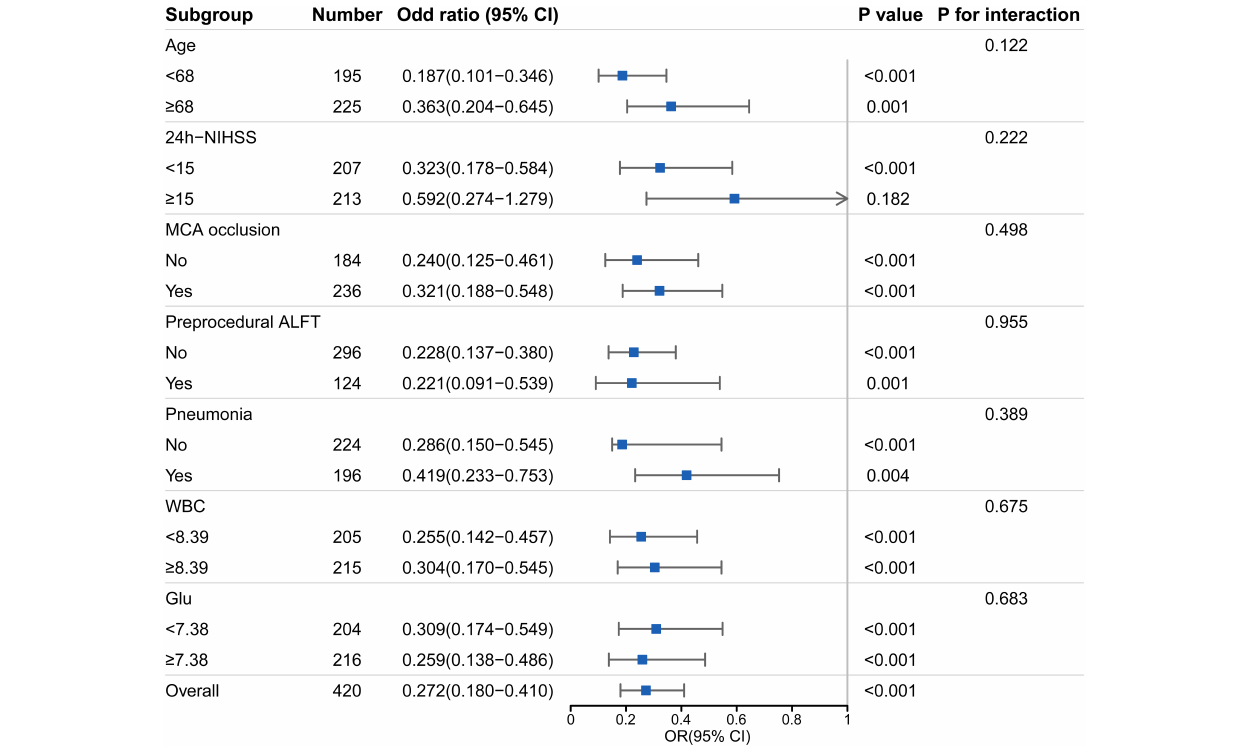
FIGURE 3 | Subgroup analyses of the association between post-procedural ALFT and the favorable prognosis. This forest plot shows the odds ratio for favorable prognosis (90-day modified Rankin scale scores 0–2) of post-procedural ALFT in subgroups. NIHSS, National Institute Health Stroke Scale; MCA, middle cerebral artery; ALFT, abnormal liver function; WBC, white blood cell; mRS, modified Rankin scale; OR, odds